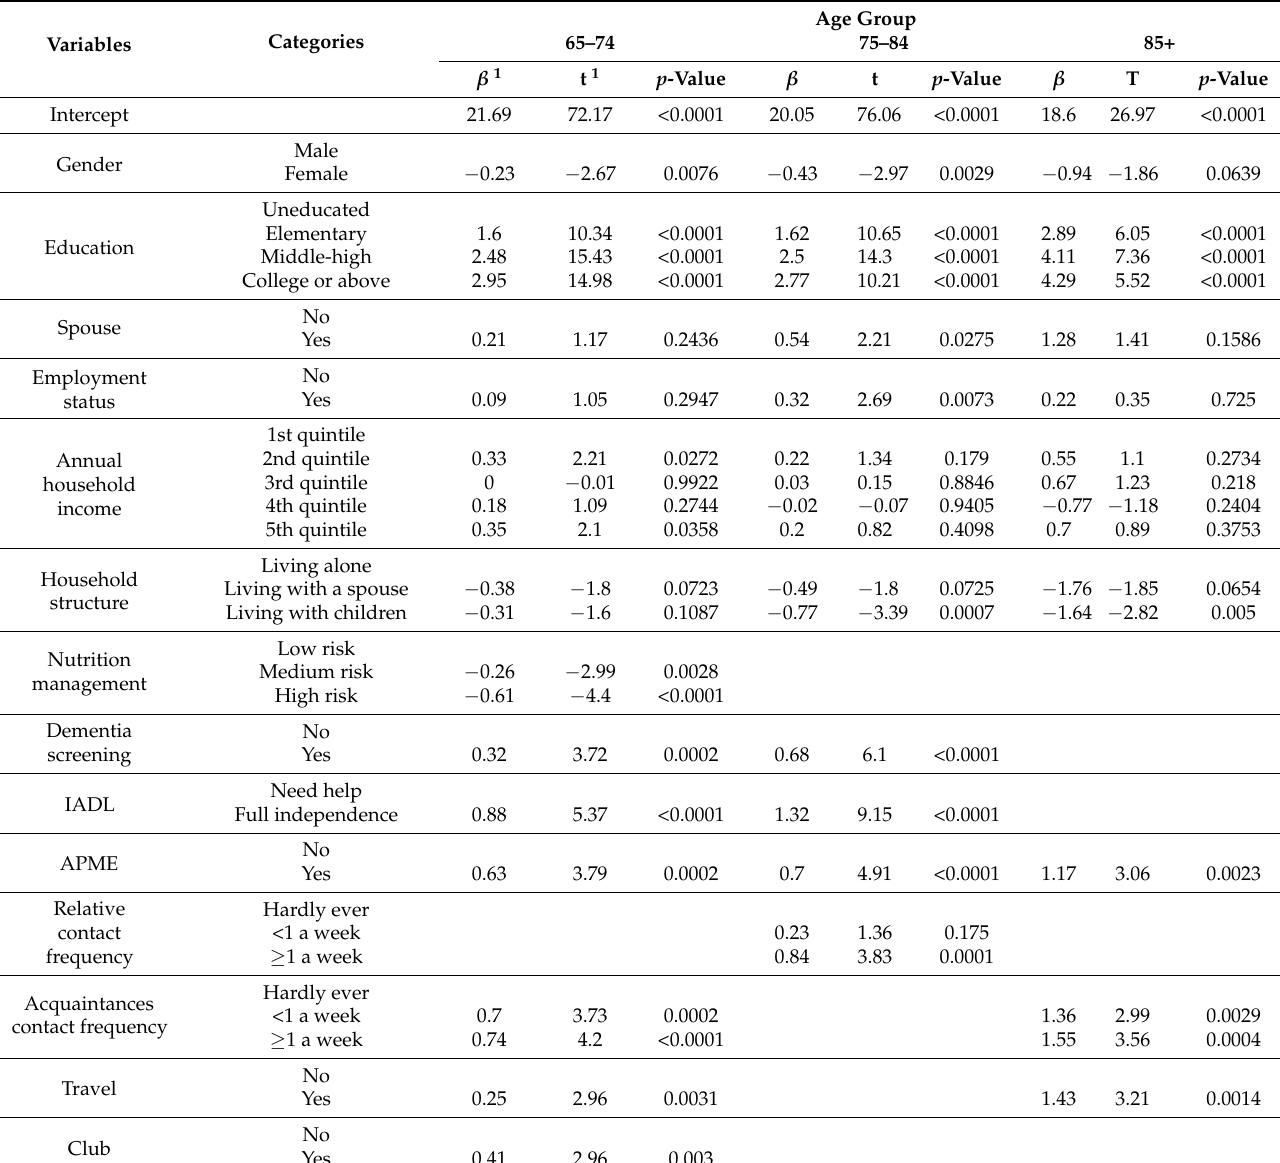
Table 3. Final regression models on MMSE after controlling the sociodemographic characteristics by age group 1 .